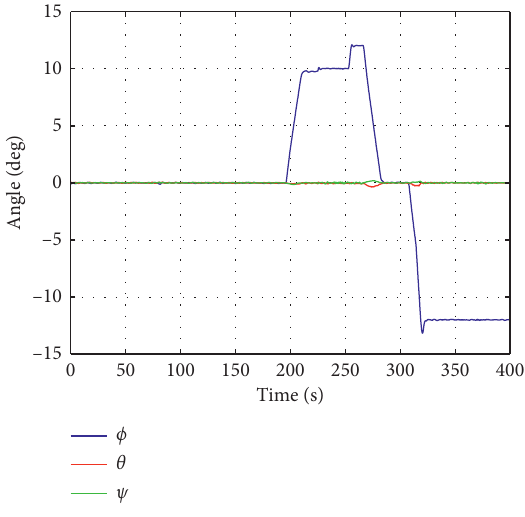
Figure 10: Actual attitude angle.